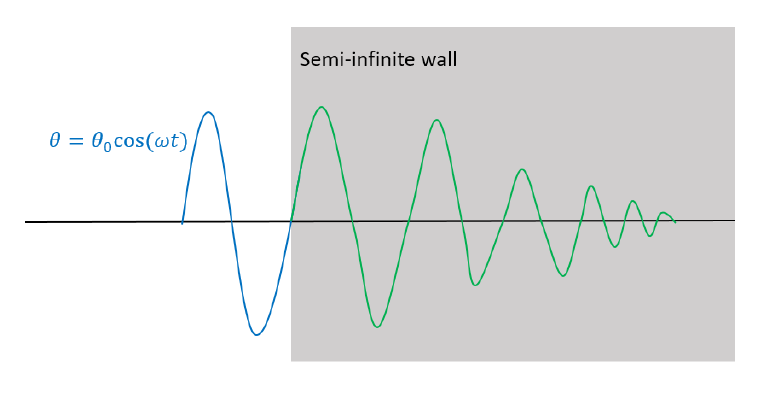
Figure 8. Harmonic time-dependent variation imposed at the boundary of a semi-infinite